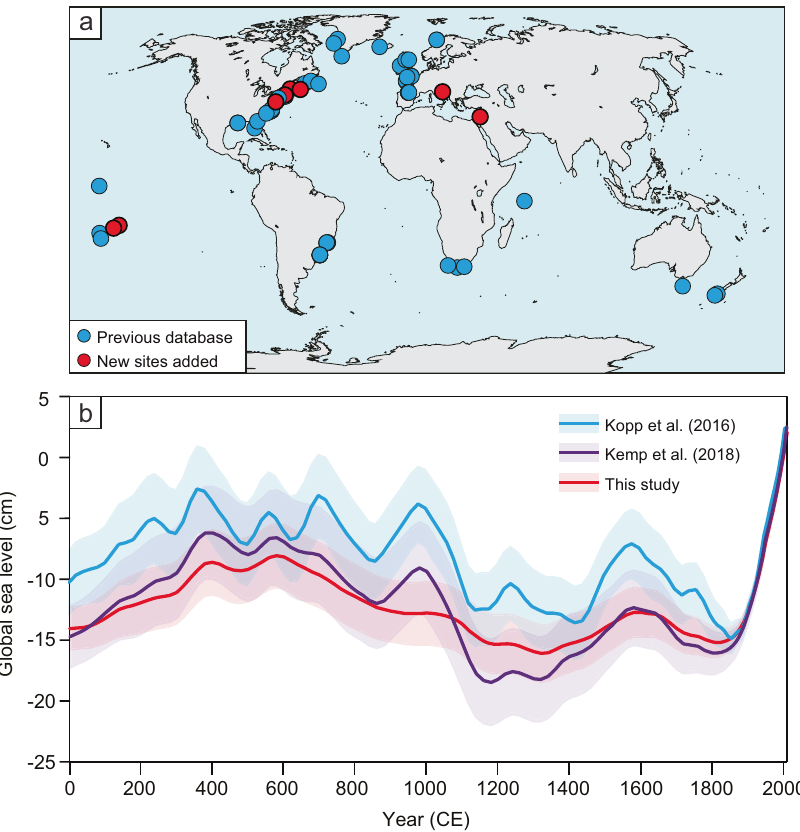
Fig. 3 Global sea-level contribution. a Proxy sea-level records in the Common Era sea-level database, where new sites updated from Kemp et al. 16 are shown in red. b Reconstructed global sea level from this study compared to the results from Kopp et al. 11 and Kemp et al. 16 . Model predictions are the mean with 1 σ